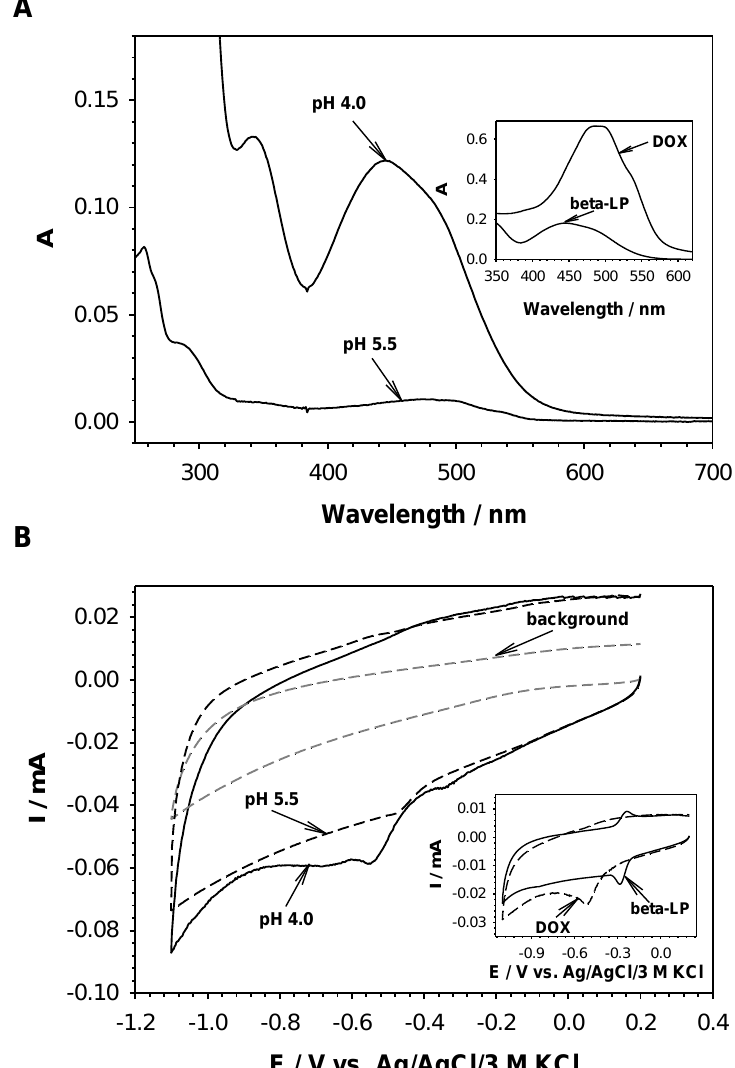
Figure 6. UV-vis spectra ( A ) and cyclic voltammograms ( B ) of the eluates obtained at pH 5.5 and 4.0. Insets: UV-vis spectra ( A ) and cyclic voltammograms ( B ) of DOX and beta-LP. Inset A: UV-vis spectra of 100 µM solutions of pure DOX and beta-LP. Inset B: Cyclic voltammograms of 100 µM solutions of pure DOX and beta-LP (scan rate: 100 mV·s −1 ; glassy carbon disc electrode φ = 3 mm).